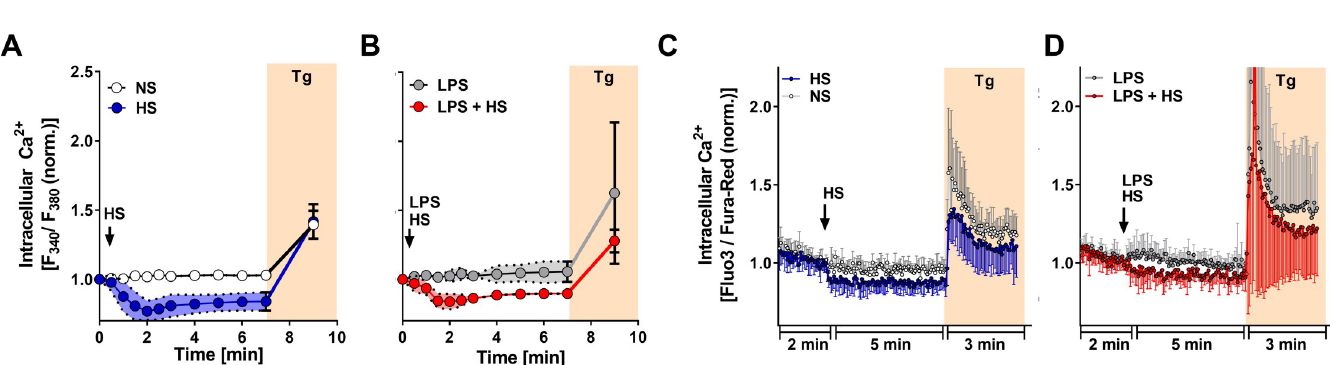
Fig 5. HS exposure causes Ca 2+ loss. (A) Relative [Ca 2+ ] i levels of RAW264.7 M F s. Traces of Fura-2–loaded RAW264.7 M F s stimulated ± HS at t = 10 s (mean ± SD; n = 6). Where indicated, Tg was added (means ± SD; n = 2). (B) As in (A), but RAW264.7 M F s were stimulated with LPS ± HS at t = 10 s (mean ± SD; n = 5). Where indicated, Tg was added (means ± SD; n = 2). (C) As in (A), but relative [Ca 2+ ] i levels were assessed in Fluo-3/Fura-Red–loaded M F s (means ± SD; n = 6). (D) As in (B), but relative [Ca 2+ ] i levels were assessed in Fluo-3/Fura-Red–loaded M F s (means ± SD; n = 8). For numerical raw data, please see S1 Data. [Ca2+] i , intracellular Ca 2+ in situ; HS, high salt; LPS, lipopolysaccharide; M F , monocyte/macrophage-like cell; Tg, thapsigargin.